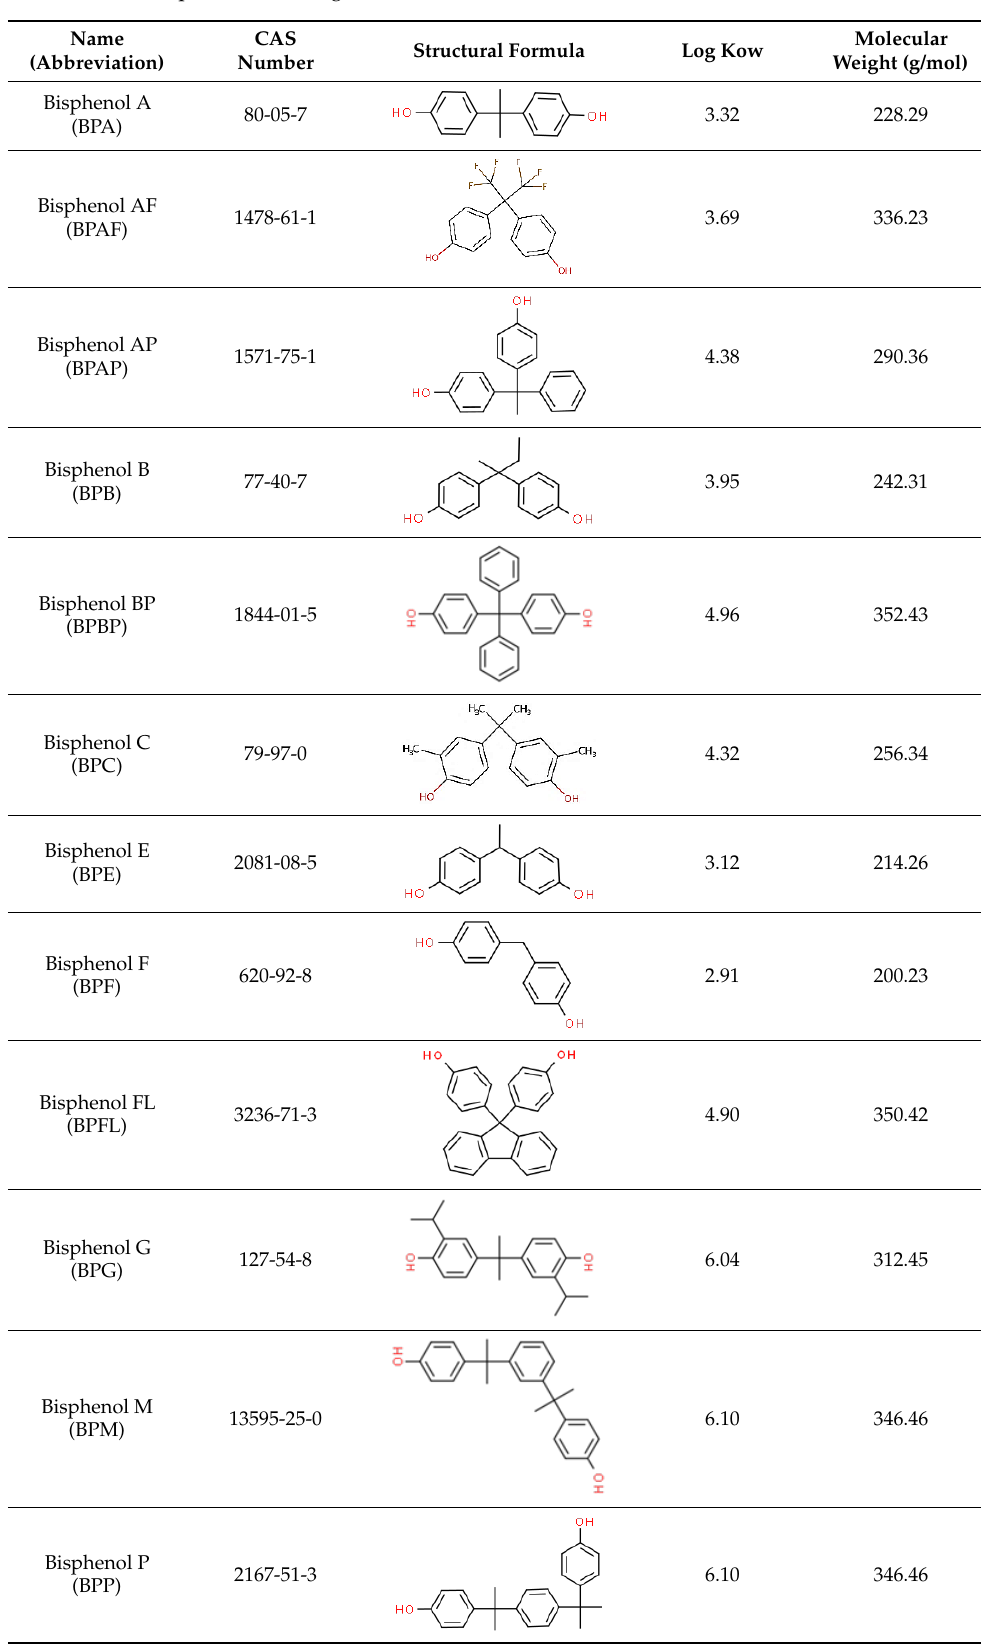
Table 1. Main bisphenol A analogs and their chemical characteristics.